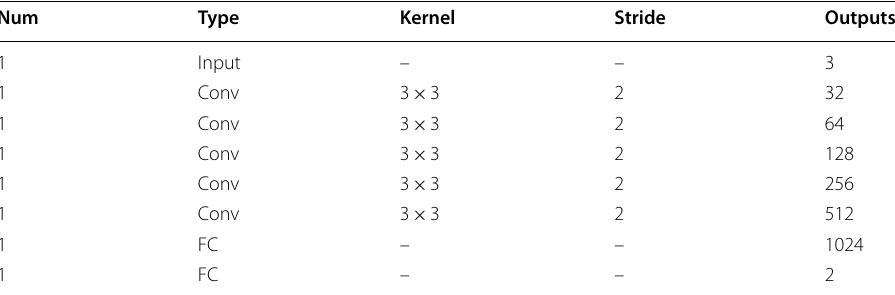
Table 2 Specification of the discriminator network